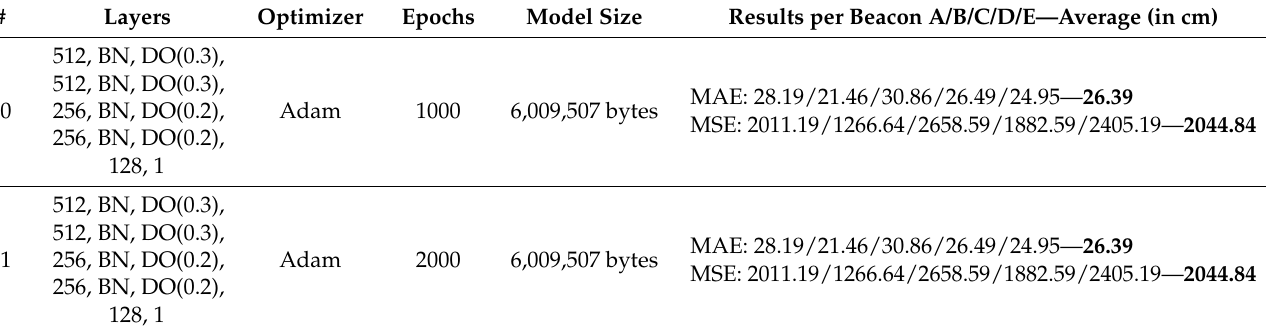
Table 9. Experiments No. 20 and No. 21 parameters and results.